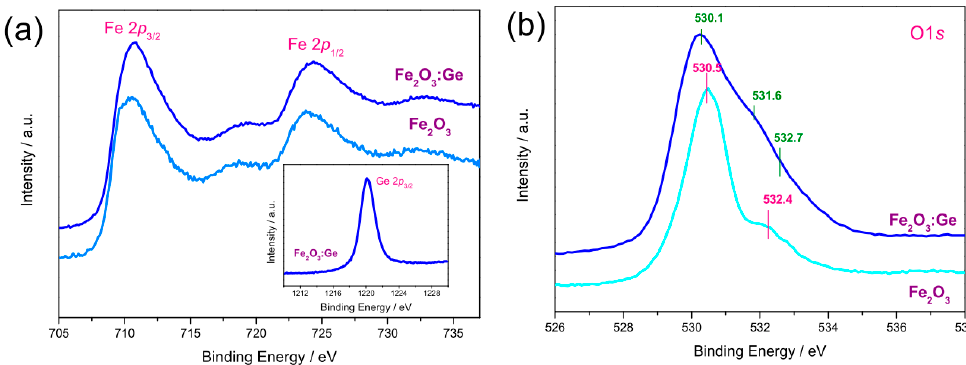
Figure 3. X-ray photoelectron spectra of ( a ) Fe 2p and ( b ) O 1s core levels. Inset to plot ( a ): Ge 2p core level in Fe 2 O 3 :Ge